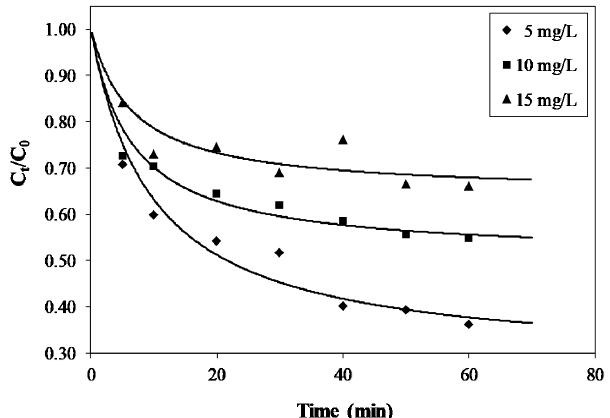
Figure 4. Plots of dimensionless concentration vs. time at different initial MB concentrations. Biosorption conditions: DM-BC dosage of 0.3 g/2 L, temperature of 25 °C, and agitation speed of 200 rpm. Symbols: C t = residual MB concentration at time t , C 0 = initial MB concentration. Full lines: calculated from Equation (1) and Table 2.